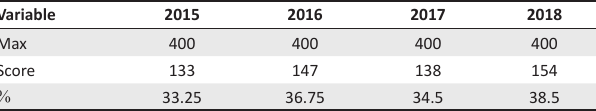
TABLE 3c: Analysis on corporate environmental disclosure in the mining sector based on present studies (case 3). Variable